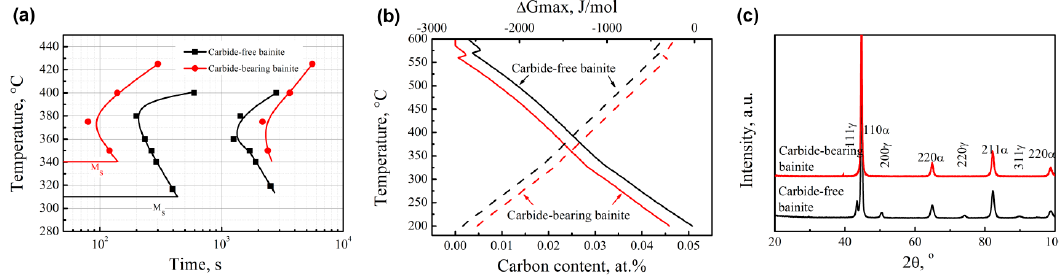
Figure 1. TTT curves ( a ), T 0 ′ curves (solid lines) and relationships between the free energy and temperature (dotted lines) ( b ), and XRD curves ( c ) of the tested steels.